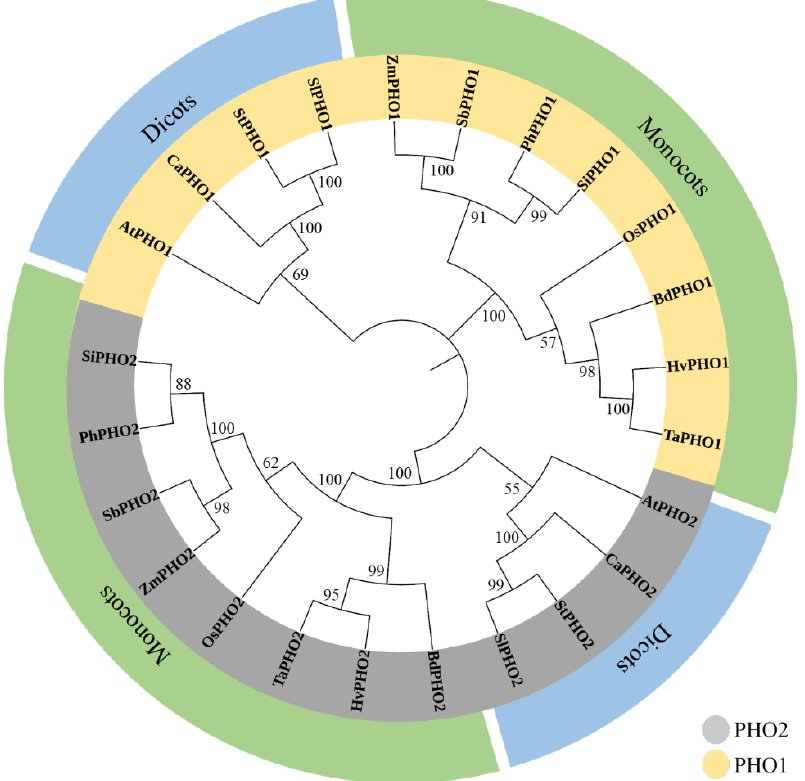
Figure 6. A phylogenetic tree constructed by the neighbor-joining method using the amino acid sequences of PHO1 and PHO2 to depict the relationship among monocots and dicots. The